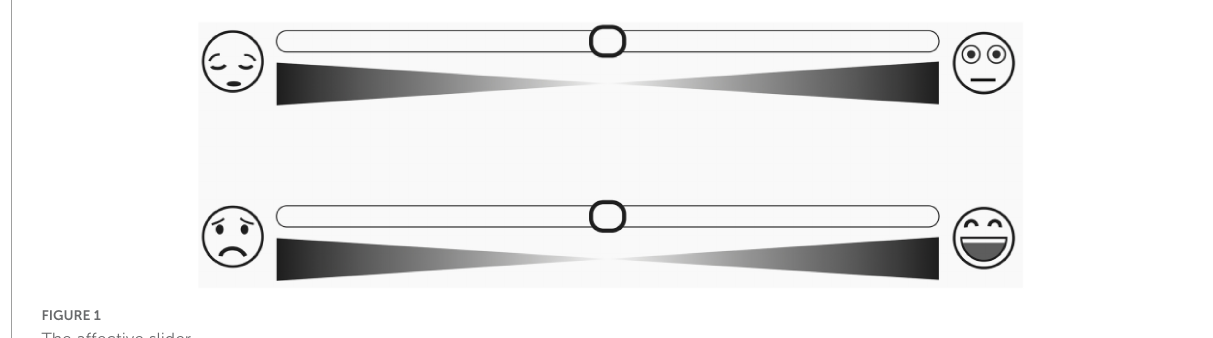
FIGURE1 The affective